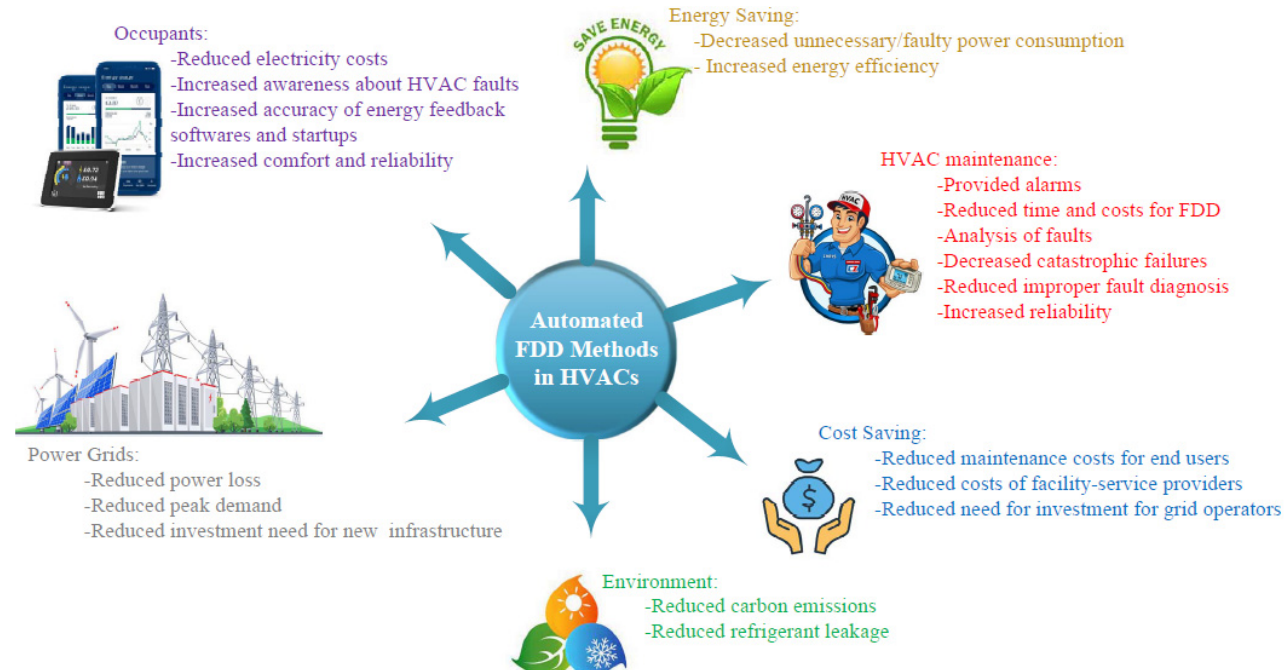
Figure 2. Benefits of automated FDD methods in HVAC applications.